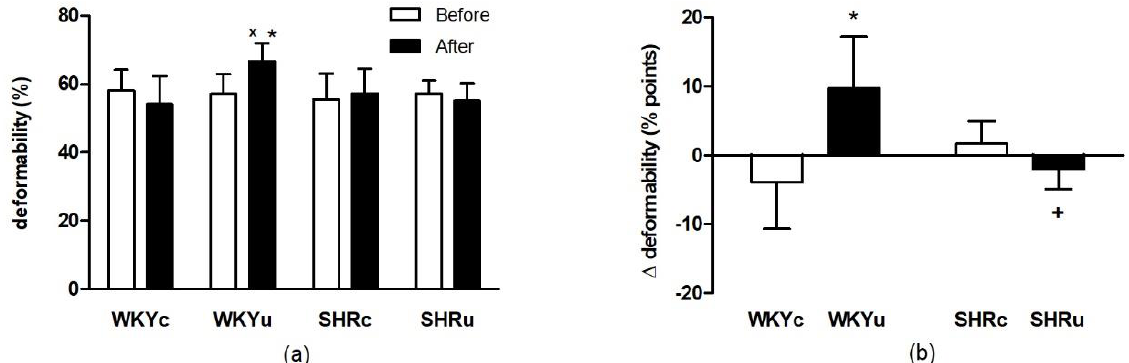
Figure 1. Red blood cell deformability determined before and after the single USPION administration at a dose of 1 mg Fe/kg body weight ( a ) and the difference in red blood cell deformability measured after the USPIONs administration and before it ( b ). Rats were killed approximately 100 min after the USPIONs administration. Abbreviations: USPIONs, ultra- small superparamagnetic iron-oxide nanoparticles; WKY, Wistar Kyoto rats; SHR, spontaneously hypertensive rats; WKYc, control WKY; WKYu, USPION-treated WKY; SHRc, control SHR; SHRu, USPION-treated SHR. The data are presented as means ± SD, n = 6–7 per group. * p < 0.05 vs. WKYc (in corresponding time point); x p < 0.05 vs. WKYu before USPION administration; + p < 0.05 vs. WKYu.